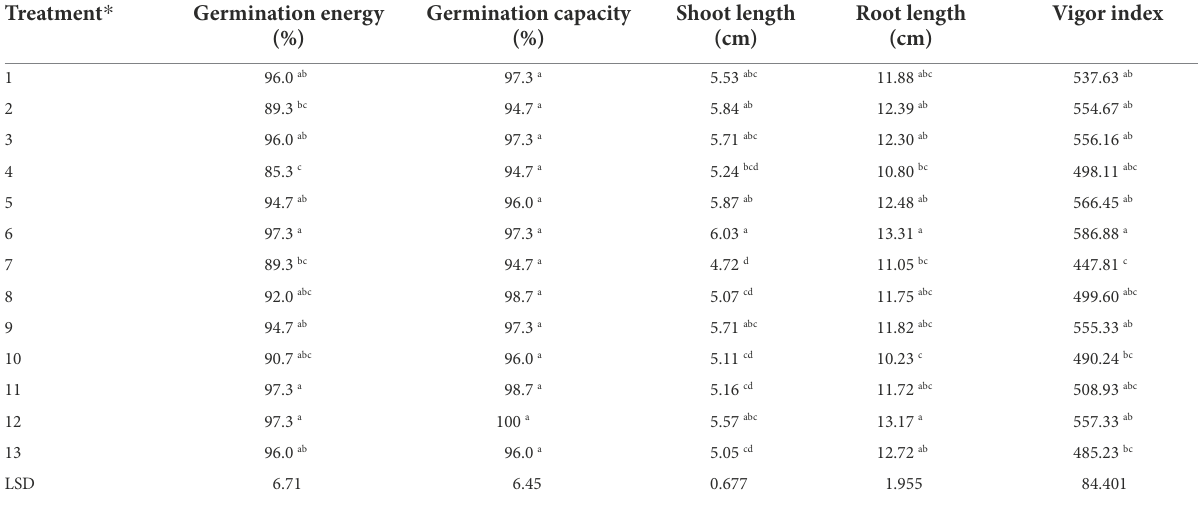
TABLE 2 Impact of applied treatments on germination energy, germination capacity, vigor index, root and shoot length of maize seeds. Treatment